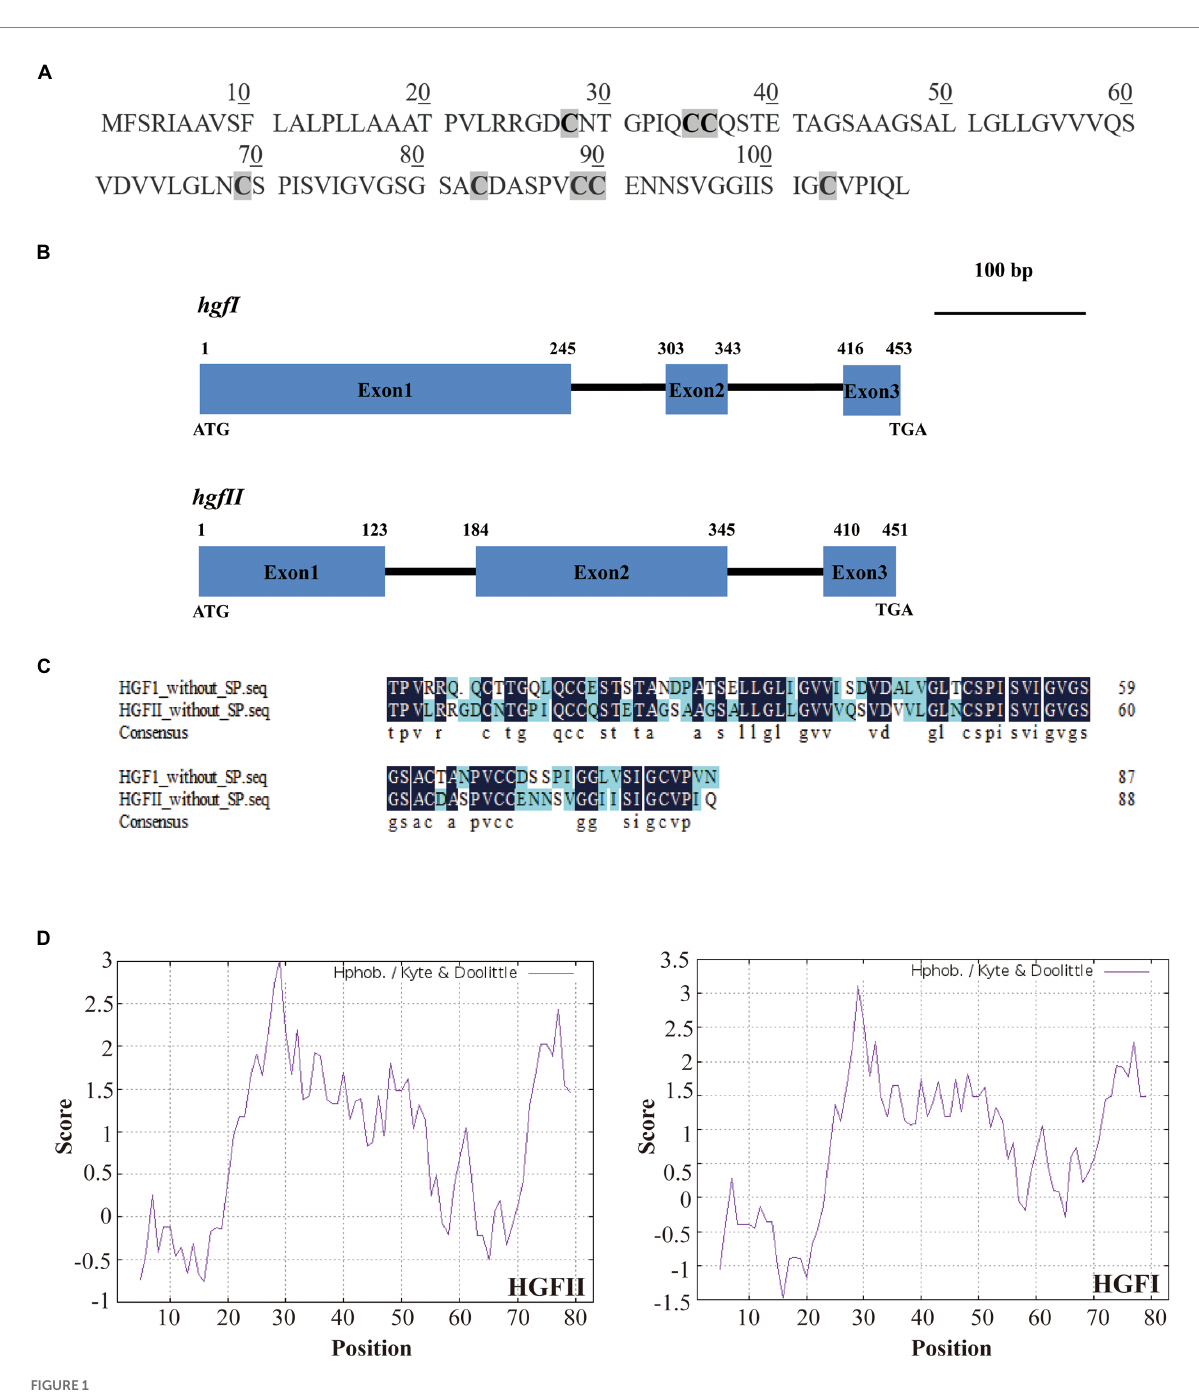
FIGURE 1 Identification and characterization of the novel hydrophobin gene hgfII . (A) The deduced protein sequence of HGFII. (B) Schematic diagram of genomic DNA sequences of hgfII and hgfI . (C) Sequence alignment between HGFII and HGFI without the signal peptides. (D) Hydropathy plot analysis of